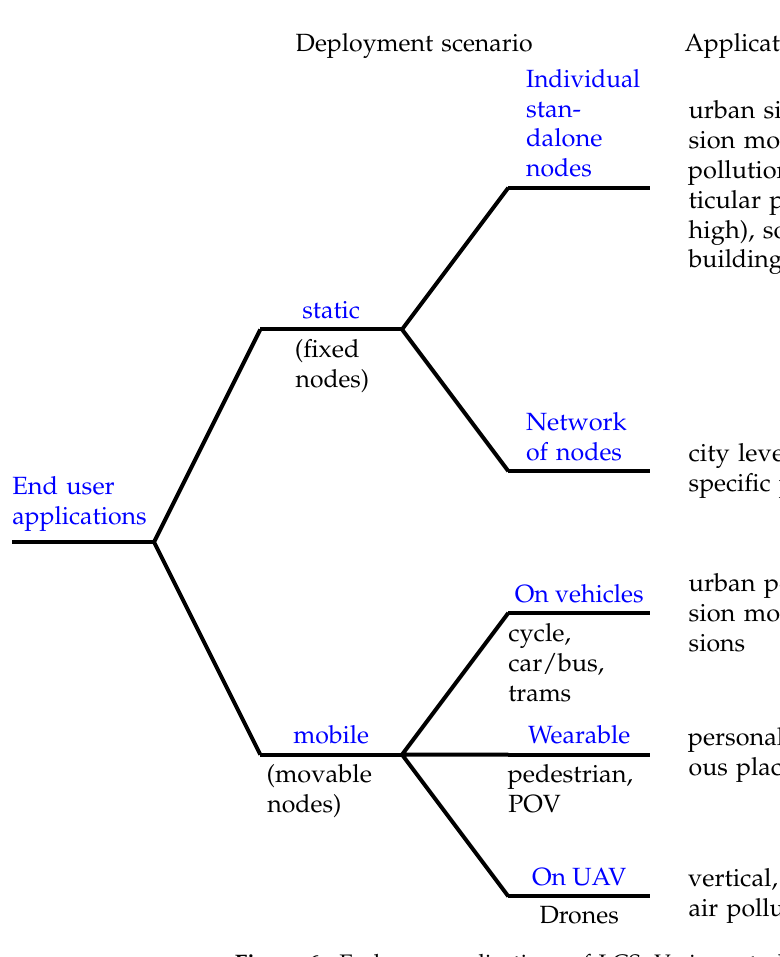
Figure 6. End-user applications of LCS. Various studies that are used LCS devices; for individ- ual standalone node applications are [91,117,120,132,154,157–163]; network of nodes applications are [21,62,79,80,119,143,164–168]; on vehicles applications are [25,81,120,168–172]; wearable appli- cations are [15,16,62,81,173–176], and on UAV applications are [36,177–182]. Here, POV stands for person on vehicle (cycle, motor bike